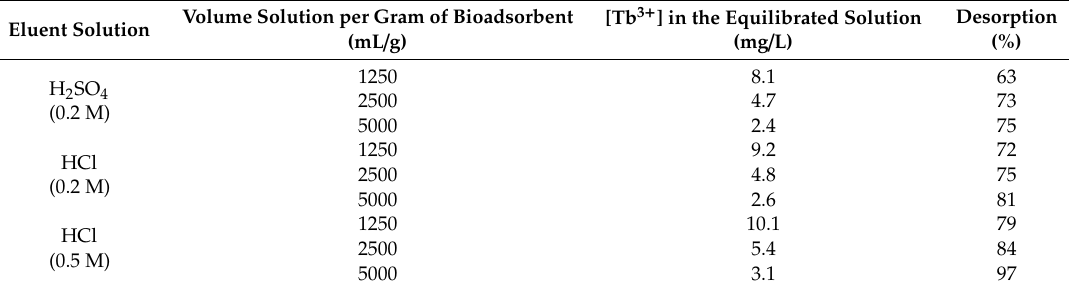
Table 4. Terbium concentration in the eluent solution and the desorption percentages for the di ff erent solutions